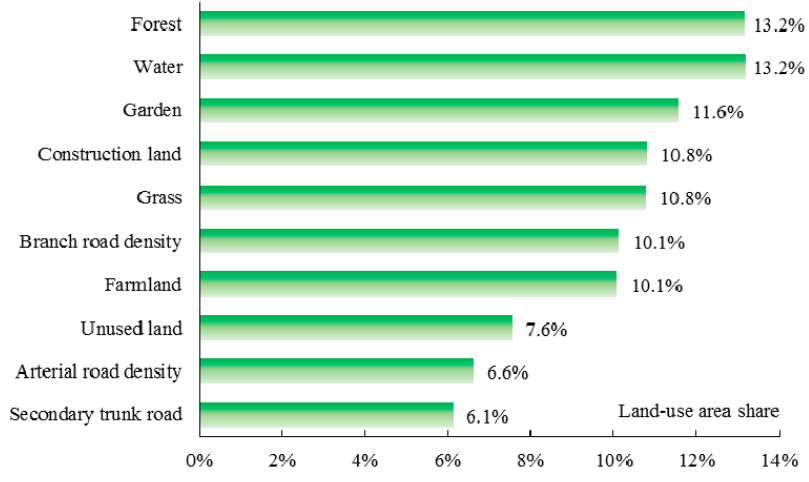
Figure 11. Relative impacts of each land-use distribution on PM 2.5 in winter.